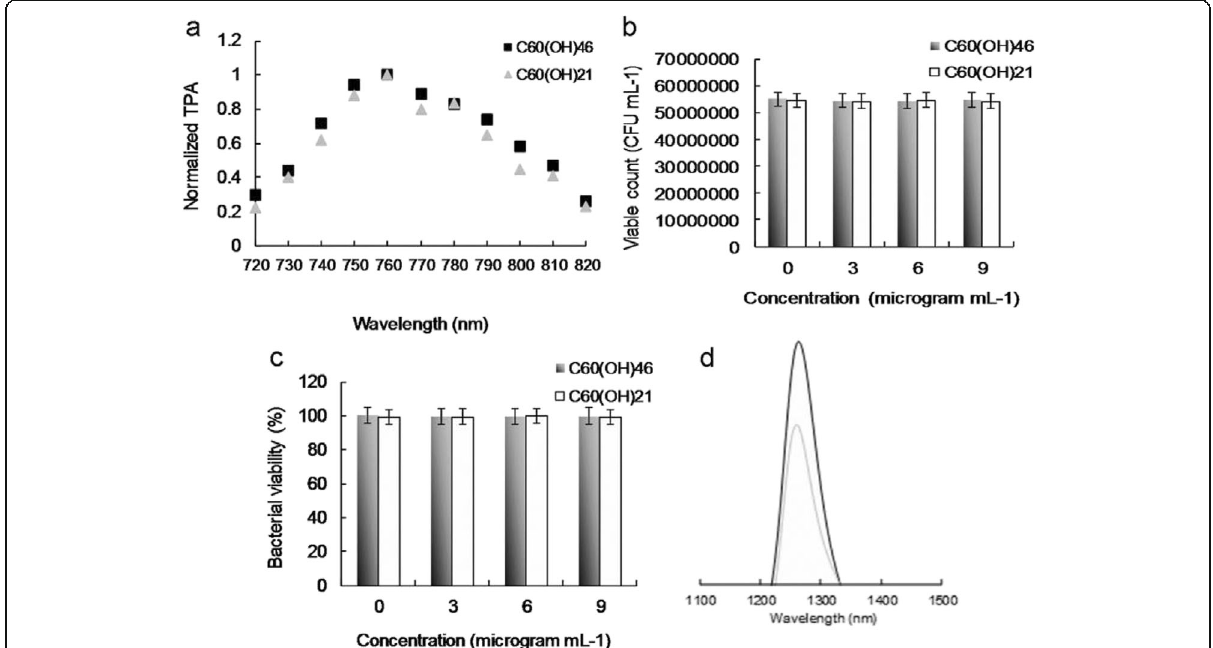
Fig. 3 a Relative TPA spectra of the material. TPE as a function of the wavelength (720 – 820 nm) at 98.56 nJ pixel − 1 that was used to monitor the signals. Delivered dose, 3 μ g mL − 1 water-soluble C 60 (OH) 46 or C 60 (OH) 21 fullerenol. The number of surviving b material-treated bacteria was determined by CFU counting assay and is expressed as the percentage (%) for c bacteria that corresponds to the unit of CFU mL − 1 . Delivered dose, OD600 ~ 0.05 of E. coli and 0 – 9 μ g mL − 1 water-soluble fullerenol. d Measurement of phosphorescence spectra at 1270 nm for material. Delivered dose, 3 μ g mL − 1 water-soluble fullerenol. Data are means ± SD ( n =